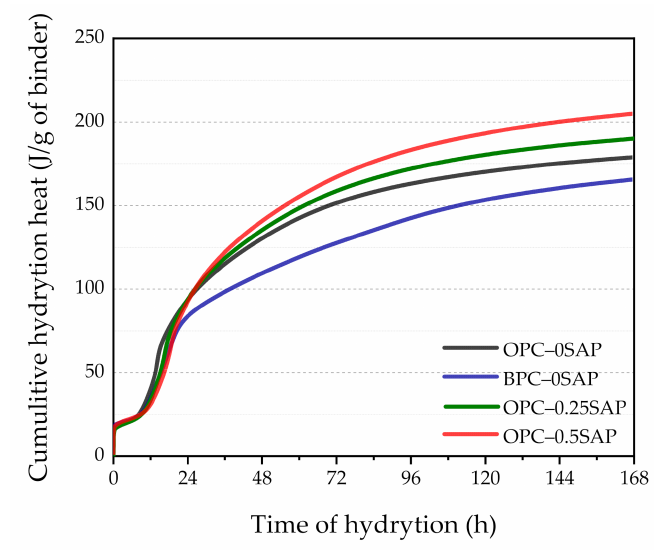
Figure 10. Cumulative heat change of the mixed paste during 72 h of